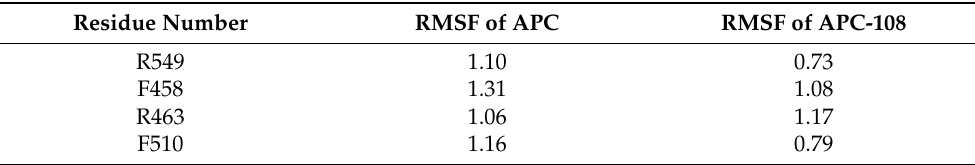
Table 1. Root mean square fluctuation (RMSF) values (Å) for R549, F458, R463, and F510 in APC, APC-108, APC-Asef, and